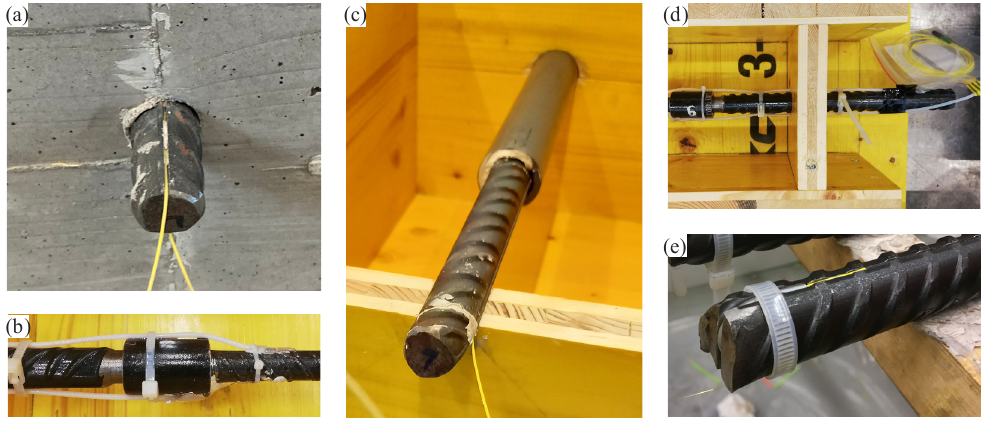
Figure 4. Examples of instrumenting embedded reinforcing bars with DFOS: ( a ) leading out the fibre with simple protection; ( b ) passing couplers; ( c ) placing an instrumented reinforcing bar in the formwork; ( d ) leading out the fibres with additional protection and ( e ) instrumentation of bar ends (anchorage).